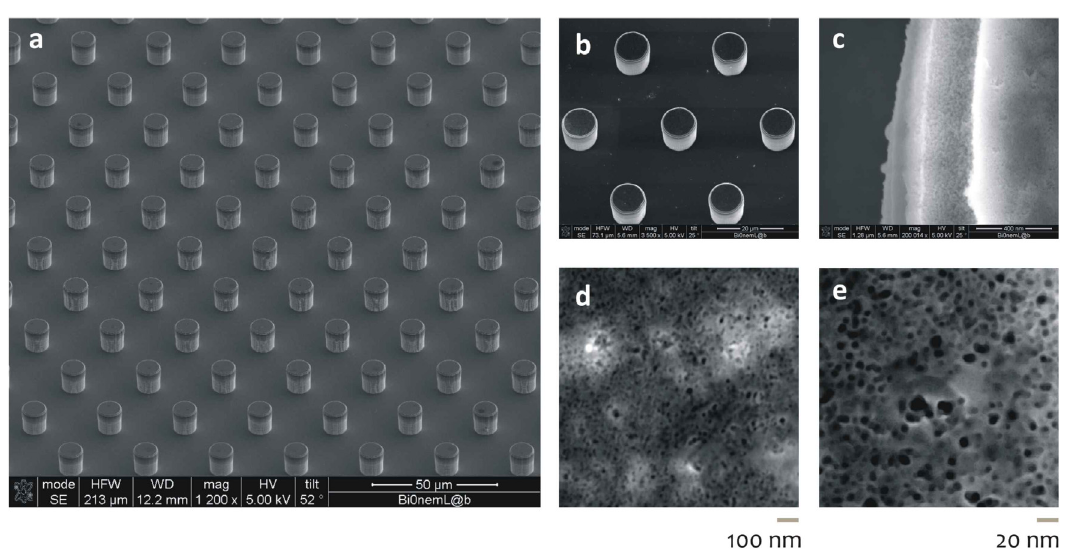
Figure 3. Nanoporous silicon devices ( a ); the silicon micropillars ( b ) reveal, at smaller scales, pores with an average pore size of 10 nm ( c – e